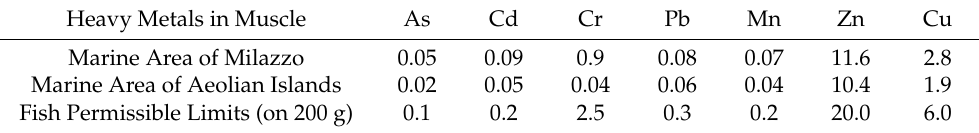
Table 2. Permitted limits of heavy metal concentrations over 200 mg in the muscle of Boops boops .